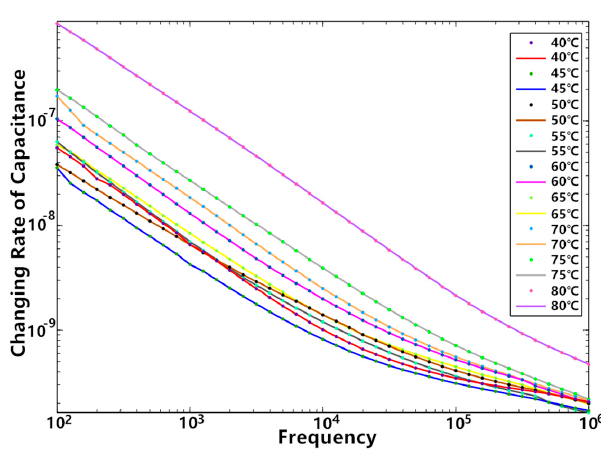
Figure 3. The change rate of capacitance at a temperature range of 40 to 80 °C.